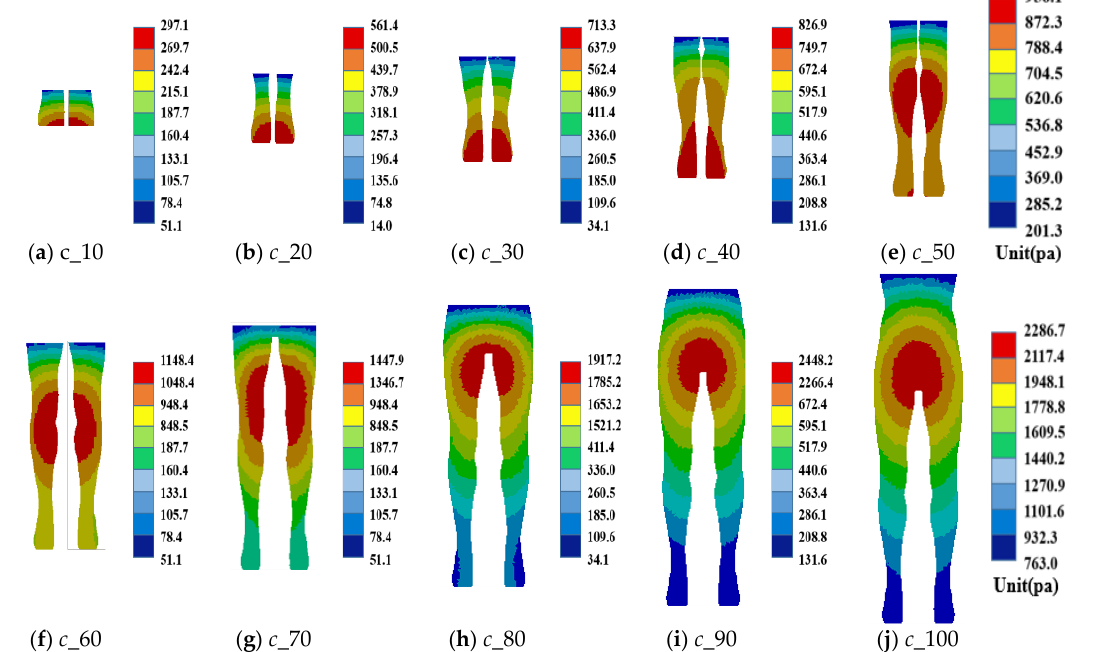
Figure 20. Hydrodynamic pressure of child walking at a minimum safe speed at different flood heights.